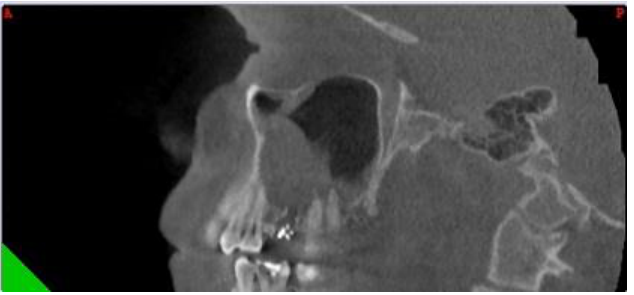
Figure 3. Sagittal CBCT of a patient with left odontogenic sinusitis and periapical fistula located at the level of the first molar, marked with a white asterix).